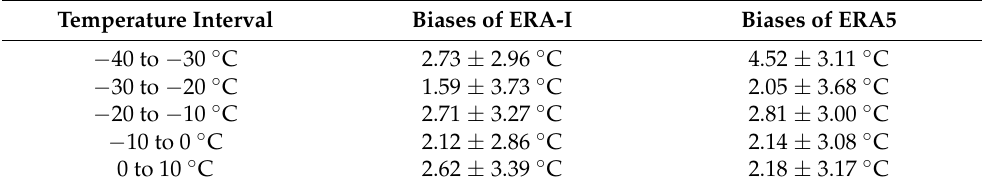
Table 2. Biases between the buoy observations and reanalysis datasets based on Ta temperature intervals.